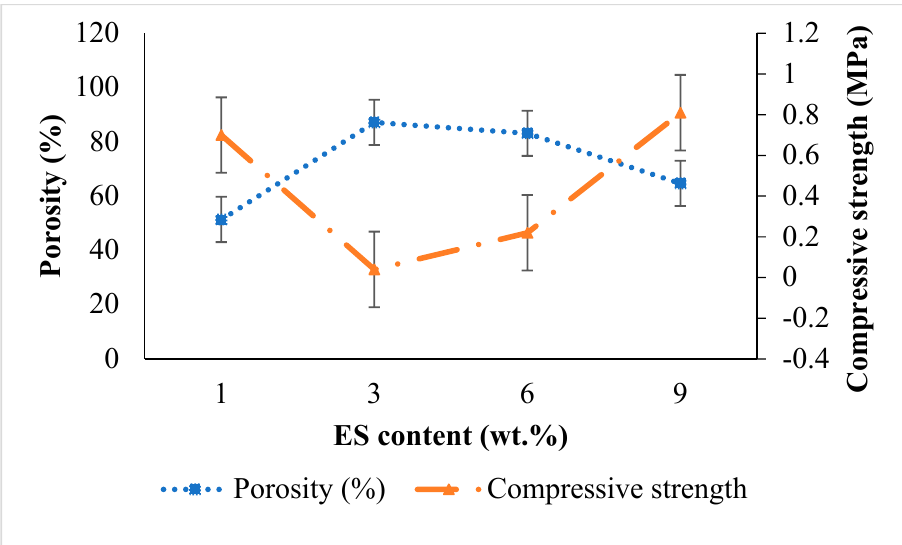
Figure 6. Linear expansion–compressive strength relative to the content of ES.